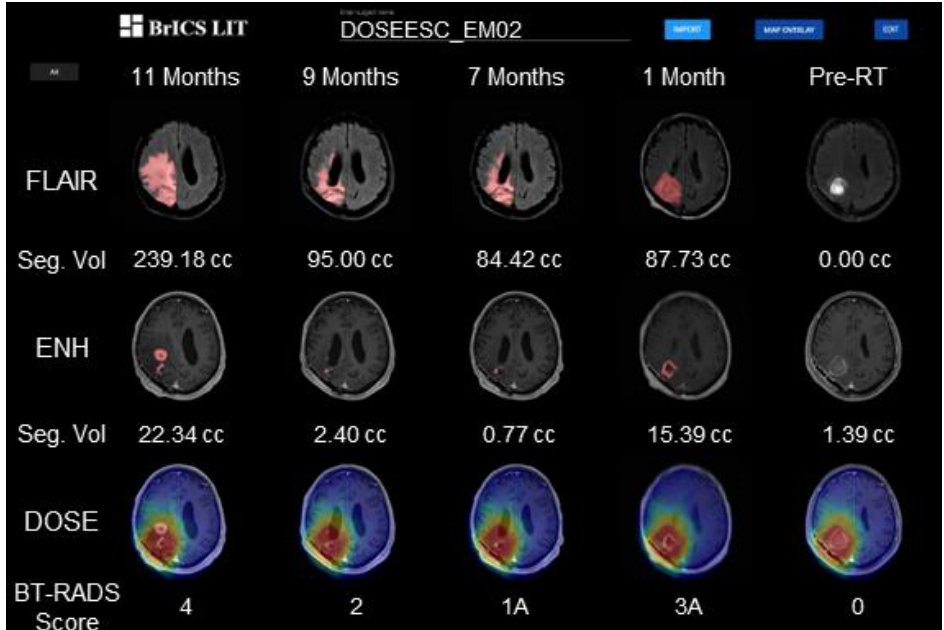
Figure 2. A view of the Brain Imaging Collaboration Suite Longitudinal Imaging Tracker (BrICS-LIT). The top row consists of T2-weighted fluid-attenuated inversion recovery (FLAIR) MRIs and the middle row of T1w-CE MRIs co-registered and interpolated to an atlas for easier comparison. Studies are longitudinally arranged from newest (left column) to oldest (right column). Segmented lesions are overlaid in the top two rows, while the radiation dose map is overlaid on the T1w-CE MRI in the bottom row to intuitively determine the radiation dose received of the suspected recurring tumor.